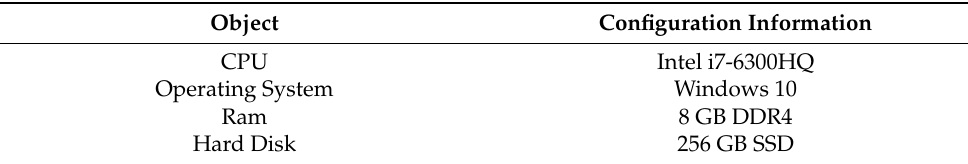
Table 1. Experimental configuration